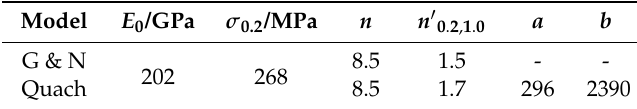
Table 4. Compressive test fitting parameters using two models.